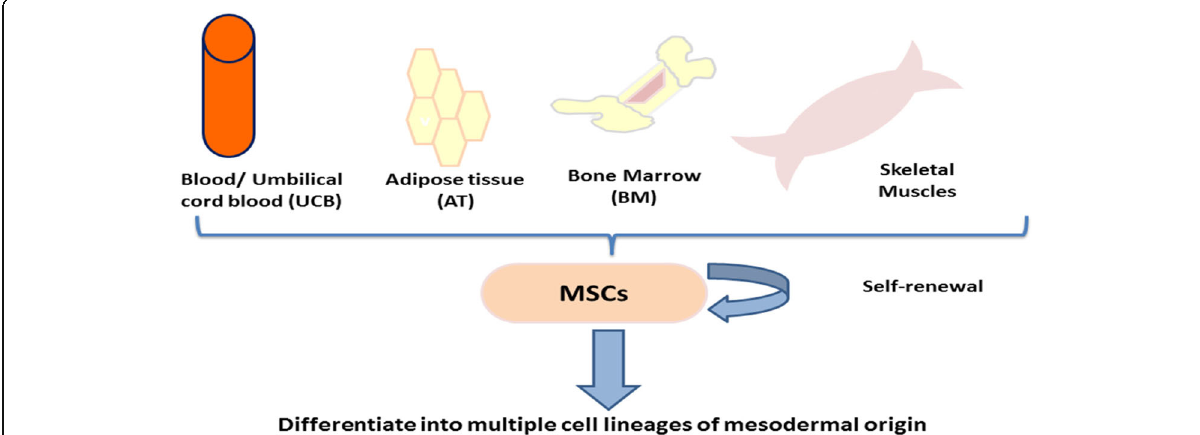
Fig. 3 Origin of mesenchymal stem cells (MSCs). MSCs can be isolated from the umbilical cord blood, bone marrow, and adipose tissue. MSCs are capable of self-renewal and differentiation into multiple cell